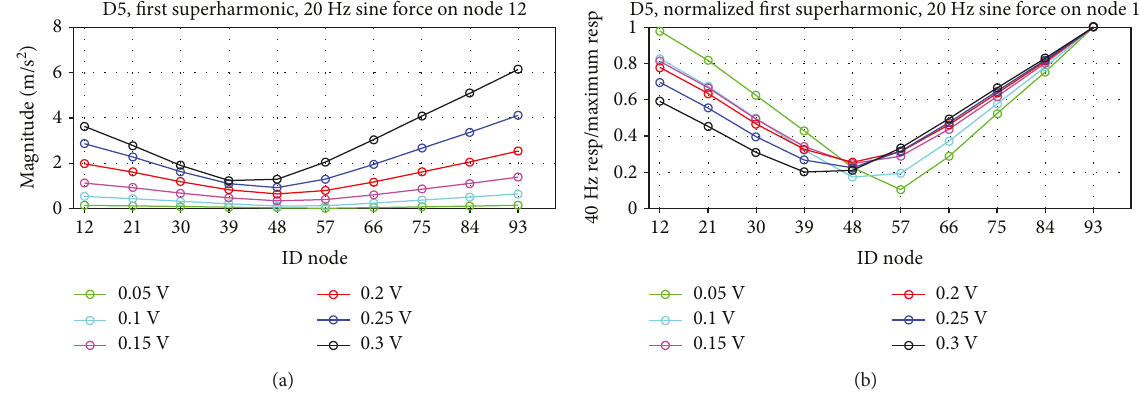
Figure 51: 40 Hz FFT magnitudes, 20Hz sine excitation force applied to node 12, D5